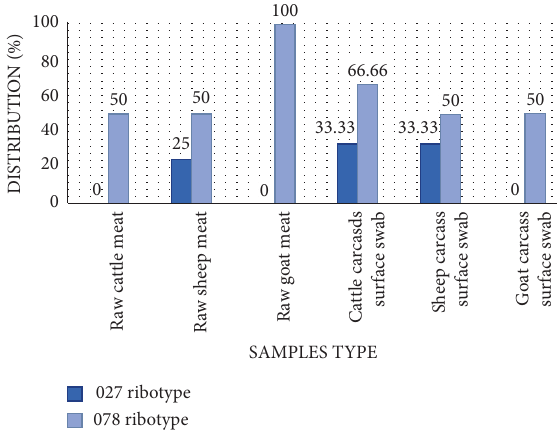
Figure 3: Distribution of 027 and 078 ribotypes of C. difcile strains isolated from raw meat and surface carcass swab